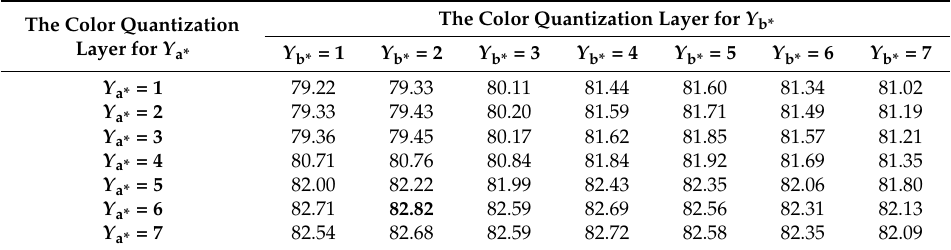
Table 5. Average precision rate (APR) of different color quantization layers on ETHZ-53. The Color Quantization Layer for Y